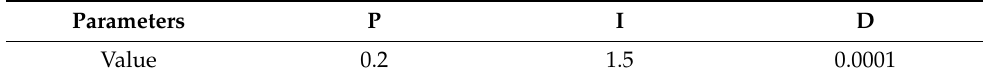
Table 3. PID parameters in the simulation.